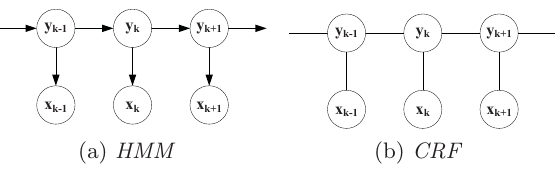
Figure 4: Graphical model of HMM and